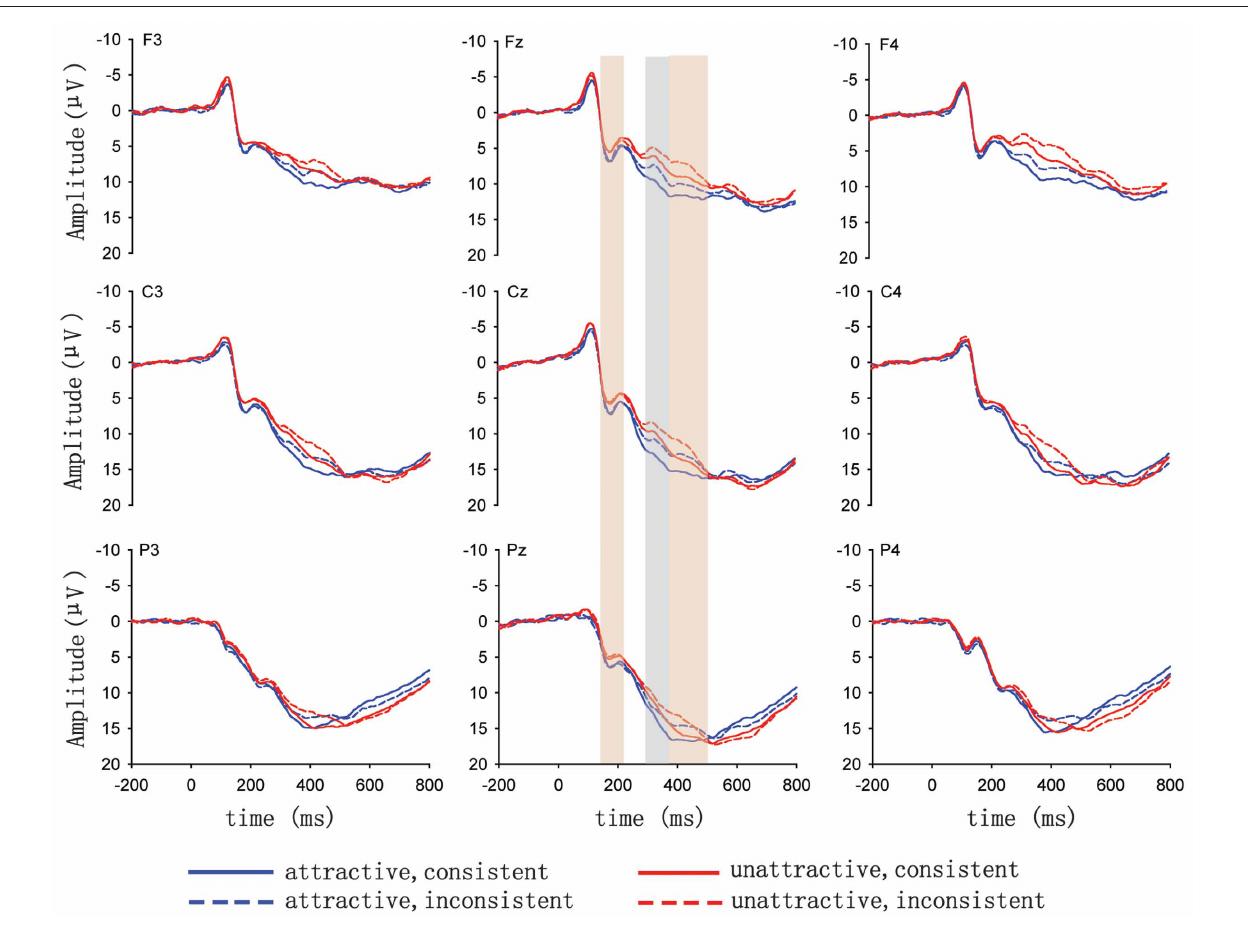
FIGURE 2 | ERP responses to feedback faces at exemplar electrodes as a function of attractiveness and feedback consistency, with 0ms corresponding to the onset of feedback